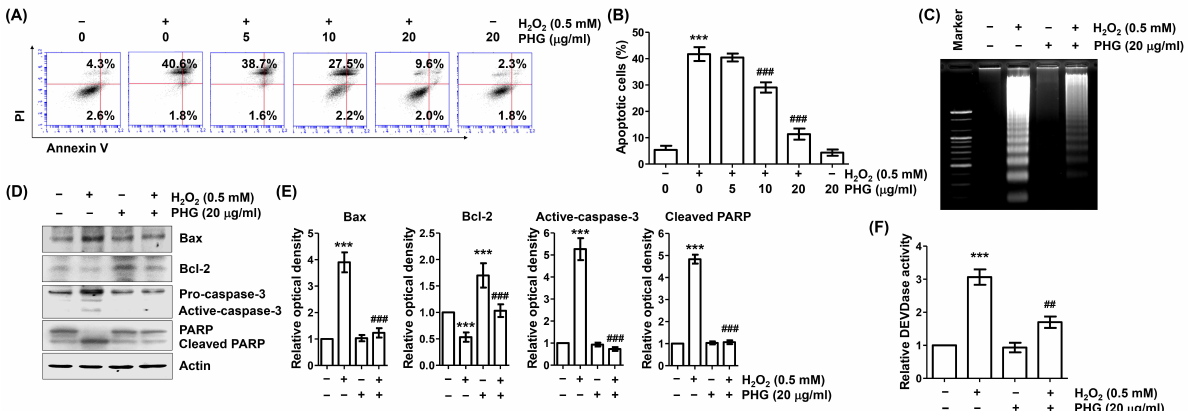
Figure 2. Phloroglucinol inhibits apoptosis in H 2 O 2 -treated ARPE-19 cells. Cells were pretreated with phloroglucinol for 1 h and then treated with or without phloroglucinol for 24 h. ( A , B ) To quantitatively measure the frequency of apoptosis induction, flow cytometry was performed after double staining with annexin V and propidium iodide (PI). Representative histograms of ( A ) and quantitative analysis ( B ) are shown. ( C ) DNA isolated from cells was stained with ethidium bromide (EtBr) and then observed under UV light. ( D ) After extracting cell lysate of each treatment group, expression levels of presented proteins were investigated through immunoblotting. ( E ) Bar diagram showing the relative protein density after normalization with actin based on Western blot analysis. ( F ) Activity of caspase-3 was measured by DEVDase activity assay using cytoplasmic extracts and presented as relative values compared to control. *** p < 0.001 vs. unstimulated control; ## p < 0.01 and ### p < 0.001 vs. H 2 O 2 alone